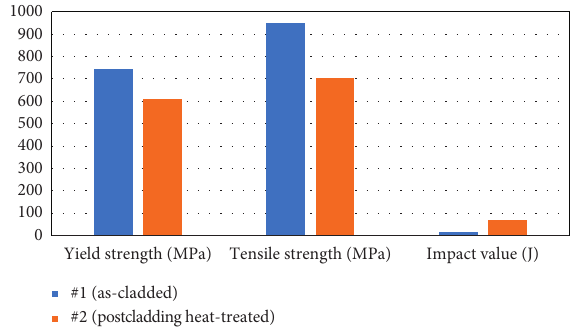
Figure 11: Mechanical properties of the 2.25Cr1Mo0.25V sample made by WAAM.